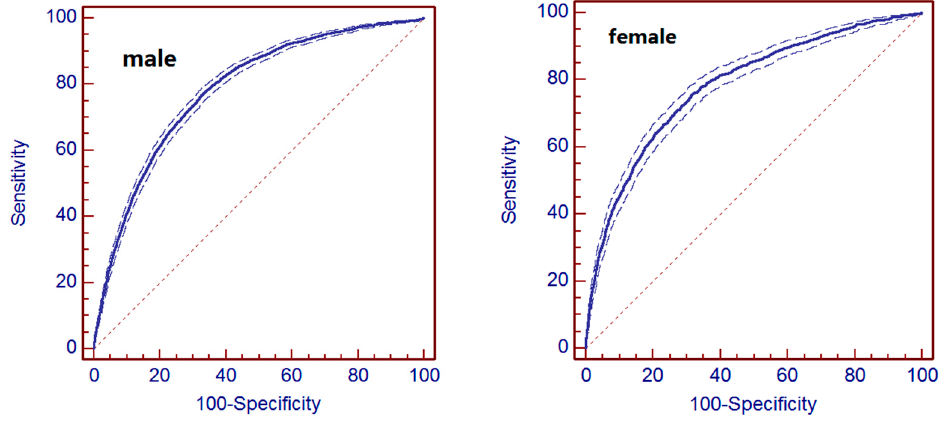
Figure 3. ROC curve for prediction of metabolic syndrome.